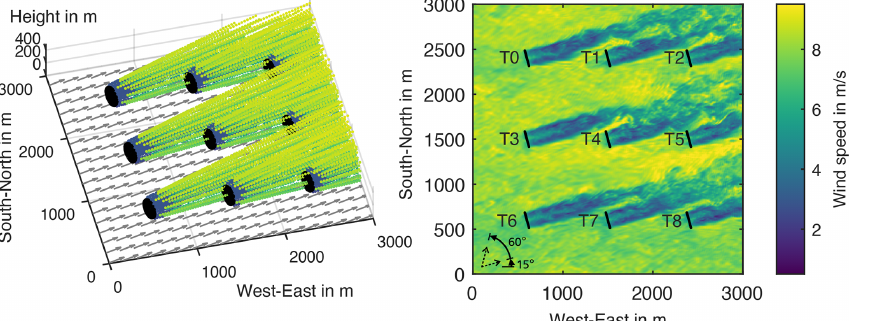
Figure 9. Complete nine-turbine FLORIDyn flow field in comparison to SOWFA at t = 600s. The wind direction change is indicated in the lower-left corner of the SOWFA plot.